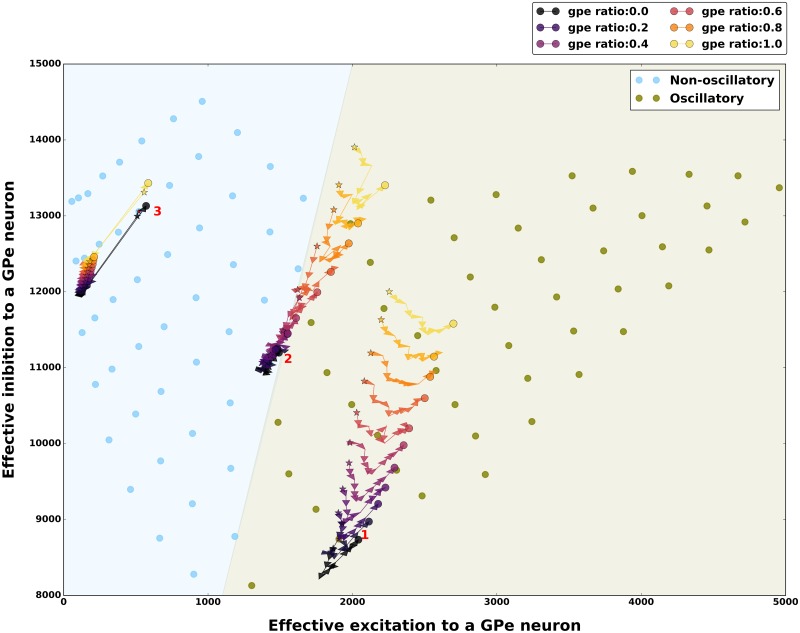
Effect of spike bursting on the excitation-inhibition balance in different network activity regimes.E-I balance was characterized by estimating the total effective excitation and inhibition received by a GPe neuron (see Methods). E-I balance for oscillatory and non-oscillatory network states for 100% non-bursting neurons. Each filled circle shows E-I balance for different external inputs to STN and GPe neurons shown in Figs 2 and 3. The effect of spike bursting on E-I balance is shown for the three exemplary network activity regimes: 1-Oscillatory regime, 2-Transition regime, 3-Non-oscillatory regime (see Fig 3 for details). Different colored stars and filled circles show how the E-I balance varied as function of change in the fraction of spike bursting neurons in the GPe (warmer colors indicate higher % of spike bursting neurons). The trajectory from the star (STN spike bursting ratio = 0%) to the filled circle shows change in the E-I balance as the fraction of spike bursting in STN is varied from 0% to 100%. In all the states spike bursting tends to make the network activity more oscillatory, however, the amount by which spike bursting is able to push the network towards oscillatory regime depends on the network activity regime itself.